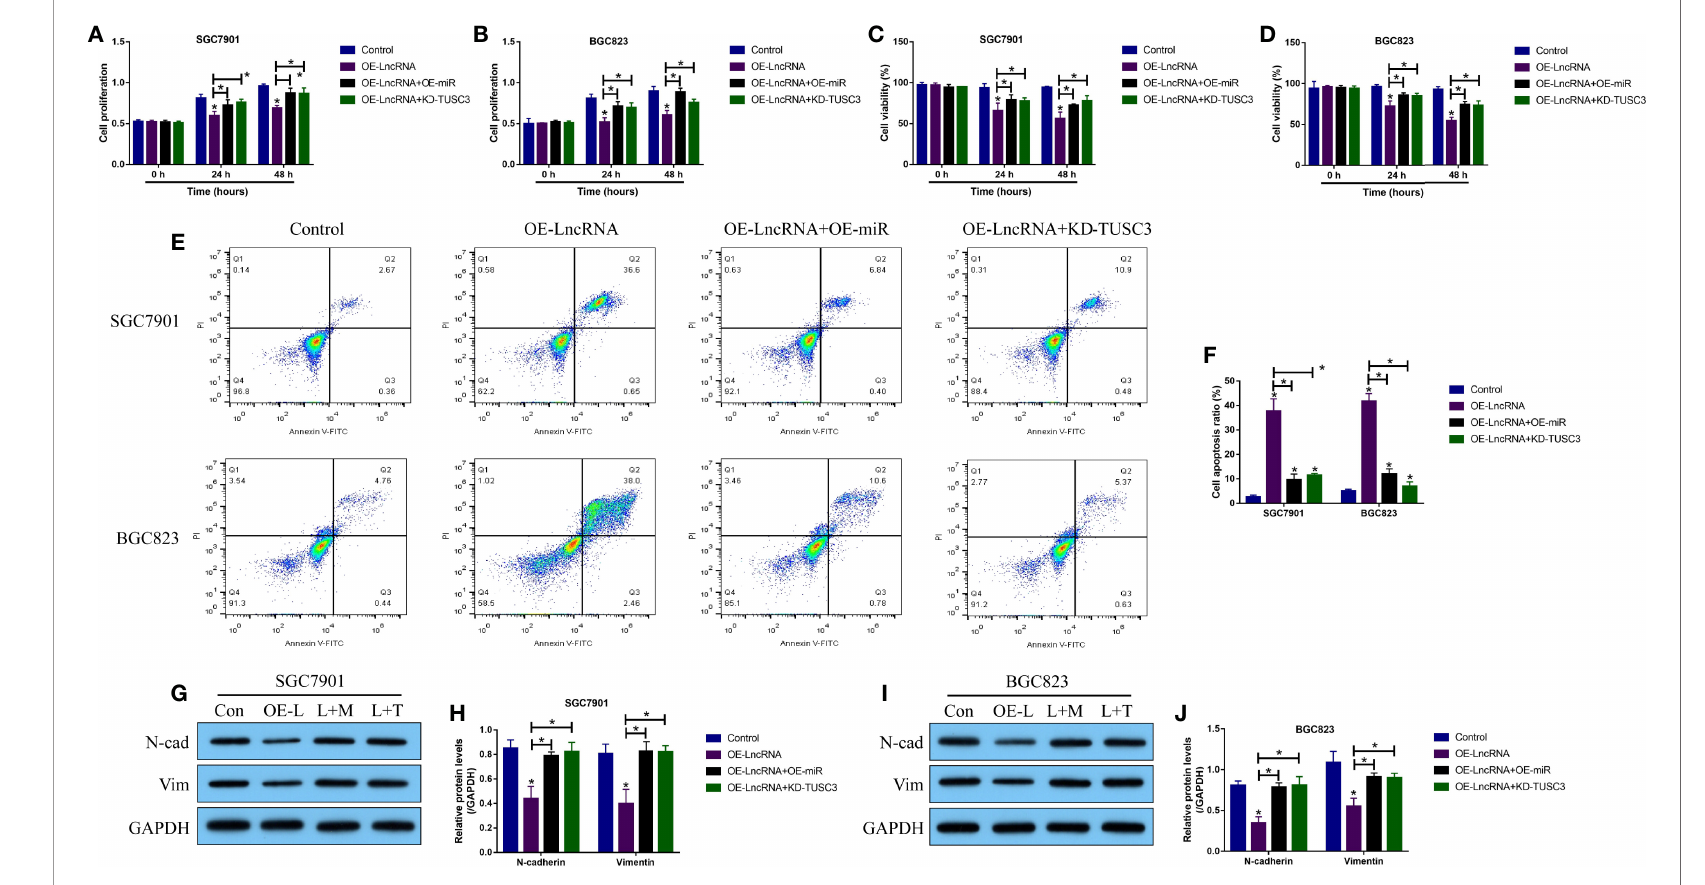
FIGURE 4 | LncRNA MIR503HG exerted its tumor-inhibiting effects by regulating the miR-224-5p/TUSC3 axis. (A, B) Cell proliferation and (C, D) viability were examined by using the MTT assay and trypan blue staining assay, respectively. (E, F) The GC cells were stained with Annexin V-FITC and PI, and the FCM assay was used to examine cell apoptosis ratio. (G – J) The expression levels of N-cadherin and Vimentin were detected by Western Blot analysis. “ OE-L ” indicated “ LncRNA MIR503HG overexpression ” , “ L+M ” suggested “ OE-LncRNA MIR503HG + OE-miRNA ” , and “ L + T ” represented “ OE-LncRNA MIR503HG + KD- TUSC3 ” . Each experiment contained 3 repetitions, and P < 0.05 were marked by “ * ”